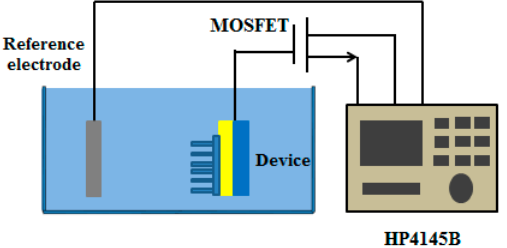
Figure 2. EGFET measurement system.